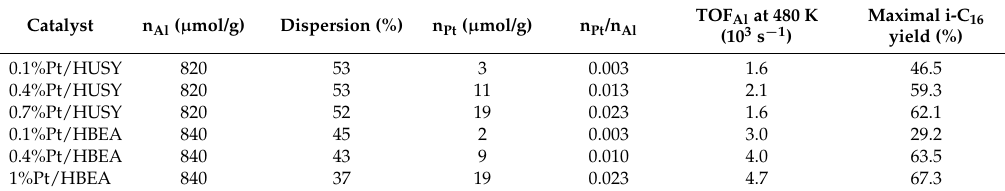
Table 7. Metal dispersions, number of accessible metal atoms, metal/acid site ratios, corresponding turnover frequency (TOF Al ) at 480 K, and maximal isomer yields estimated acid site concentrations for selected catalysts with various Pt loadings (modified from Reference